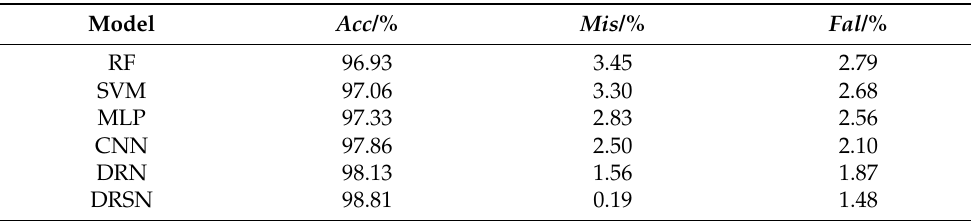
Table 1. Performance of different models on modified IEEE 39 bus